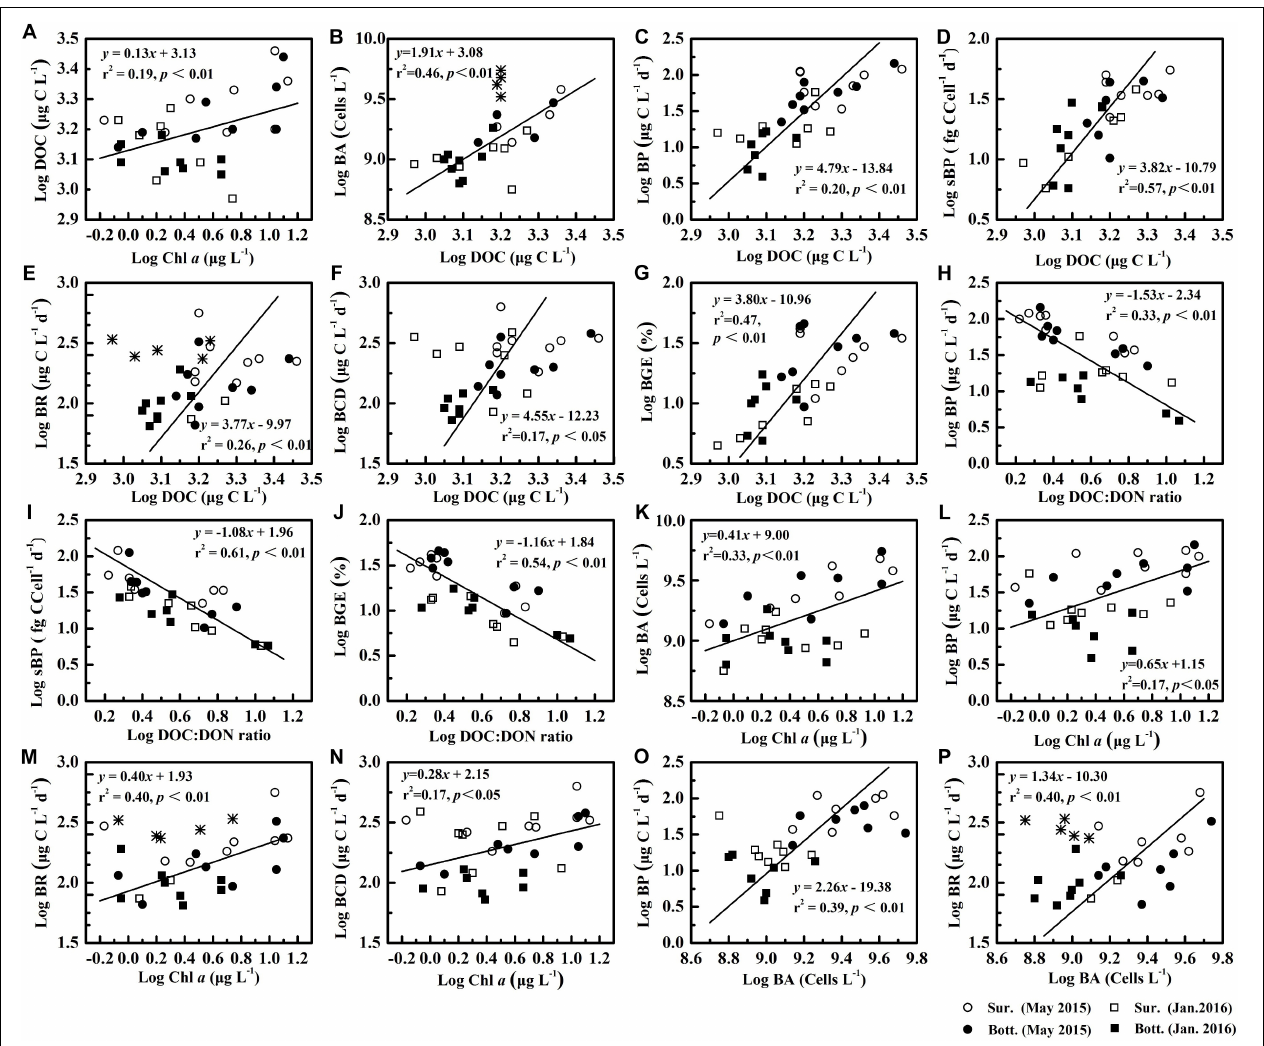
FIGURE 7 | The relationship between various variables (Chl a , DOC, DOC:DON ratio, BA, BP, sBP, BR, BCD and BGE). (cid:104) denotes the data being eliminated, including the BA in frontal area in May 2015 and BR at the surface in the lower reaches of the estuary during January 2016. The labels (A–P) are the number of each graph, and the equations and correlation coefficients between various variables are shown in Supplementary Table 3